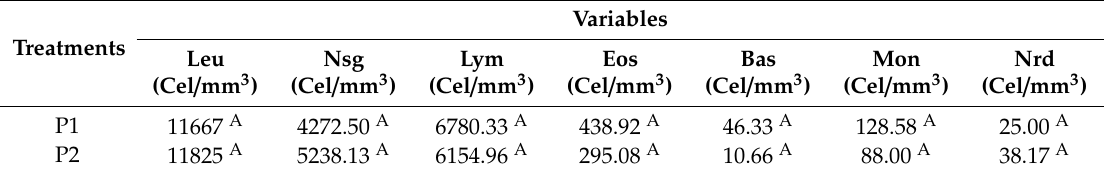
Table 3. Means of white blood cells variables in P1 and